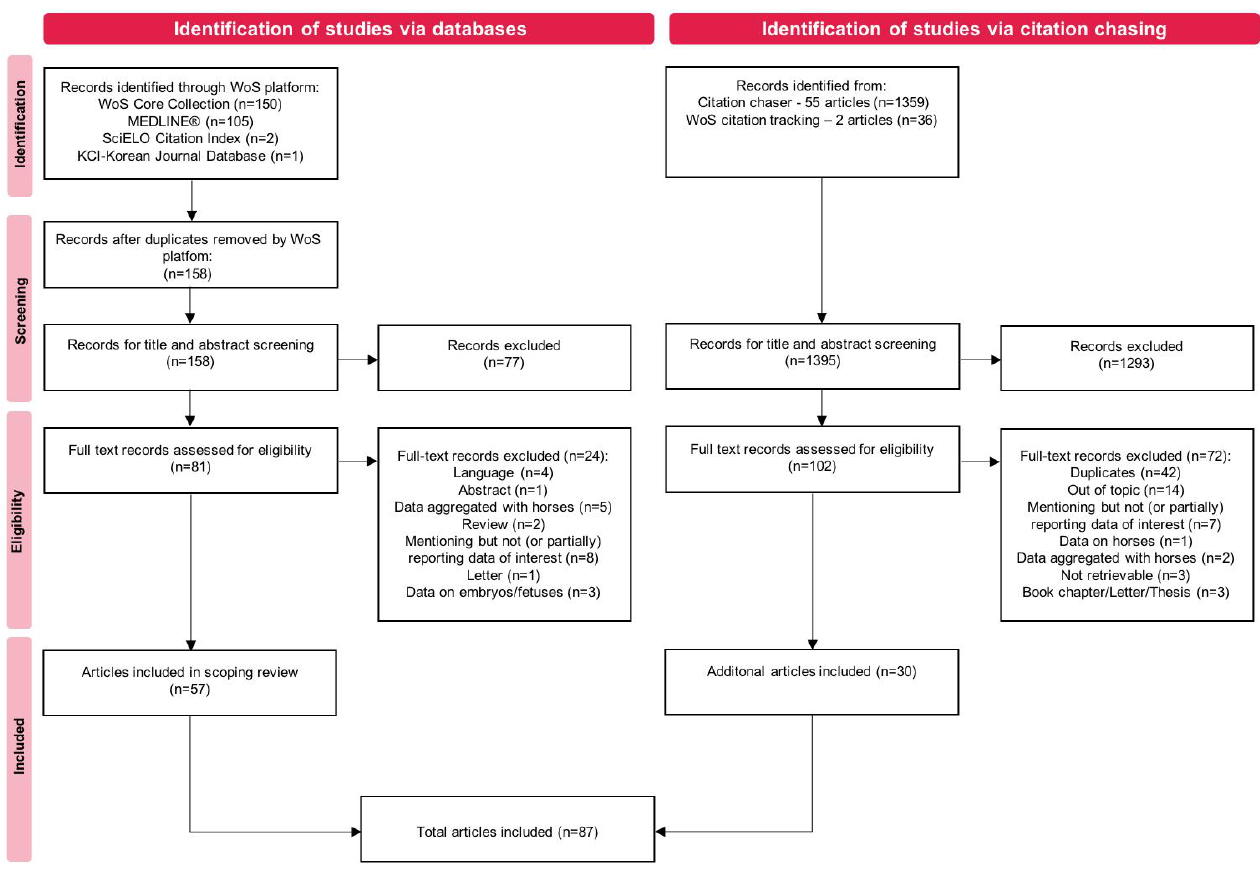
Figure 1. PRISMA flow diagram for record identification, screening, eligibility, and inclusion.